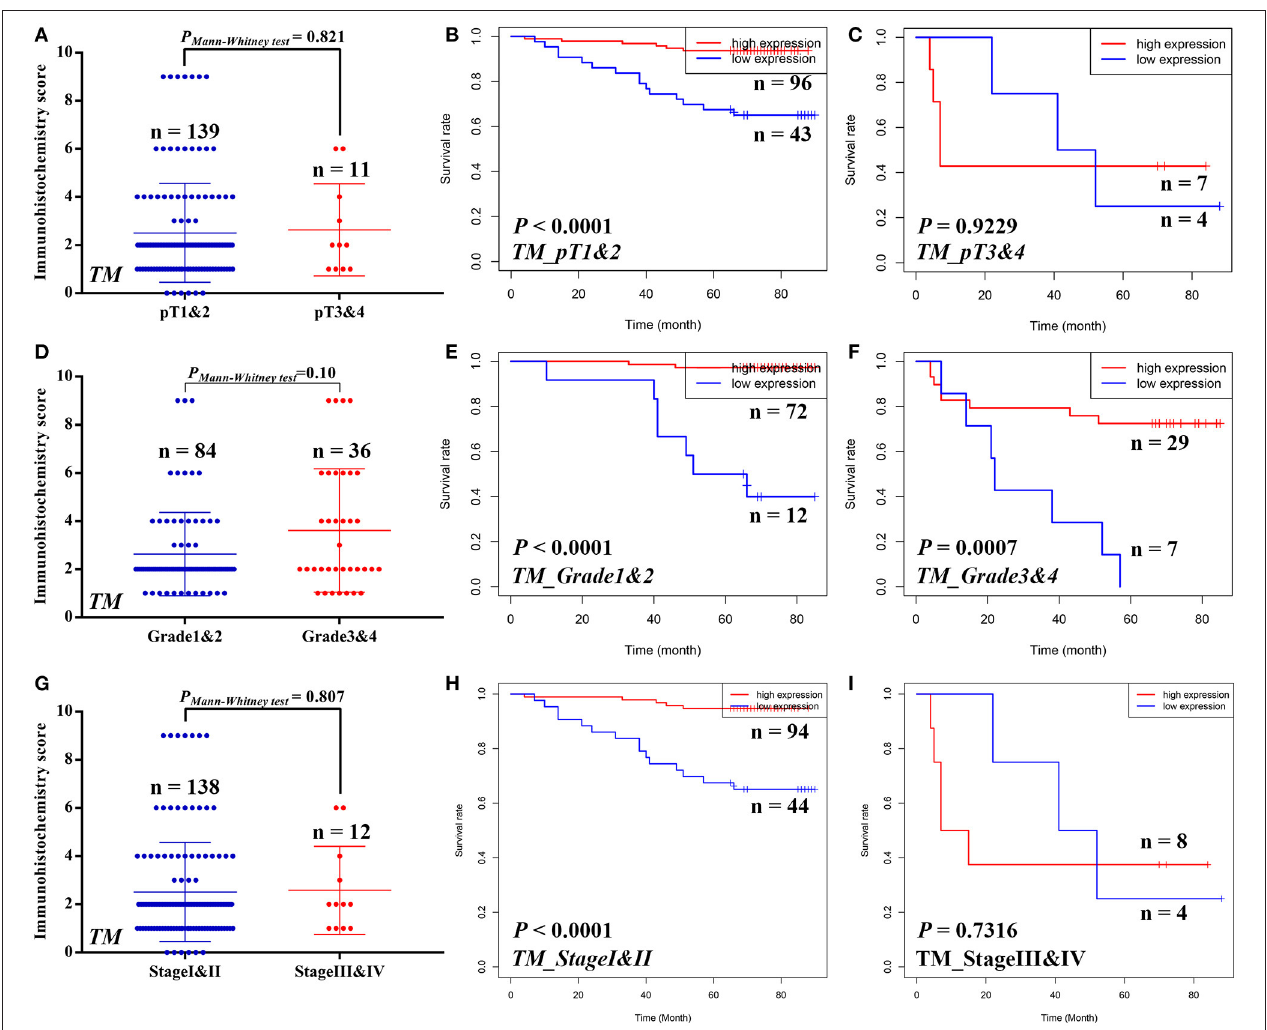
FIGURE 4 | Subgroup analyses to compare the protein expression and assess the prognostic value of STAM1 based on pT stages, tumor grades, and American Joint Committee on Cancer (AJCC) stages in clear cell renal cell carcinoma (ccRCC) patients from tissue microarray cohort. Comparison of STAM1 protein level in ccRCC patients with low and high pT stages (A) and Kaplan–Meier analyses of overall survival (OS) in patients with pT1 and 2 (B) and pT3 and 4 (C) . Comparison of STAM1 protein level in ccRCC patients with low and high tumor grades (D) and Kaplan–Meier analysis of OS in patients with grade 1 and 2 (E) and grade 3 and 4 (F) . Comparison of STAM1 protein level in ccRCC patients with low and high AJCC stages (G) and Kaplan–Meier analysis of OS in patients with AJCC stage I and II (H) and AJCC stage III and IV (I) .